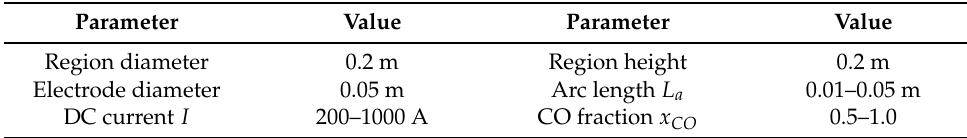
Table 1. Parameters for the 100 kVA furnace